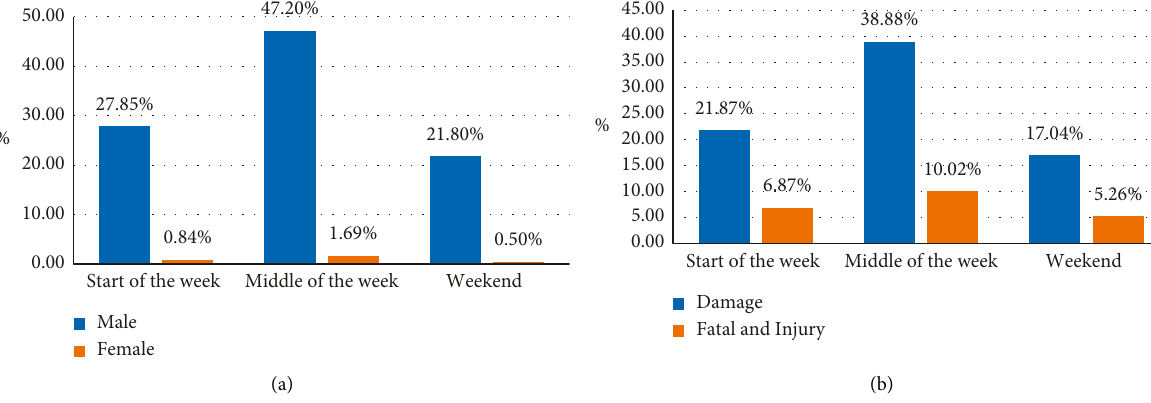
Figure 4: Statistics of vehicle accidents based on accident day: (a) gender of the driver and (b) severity of